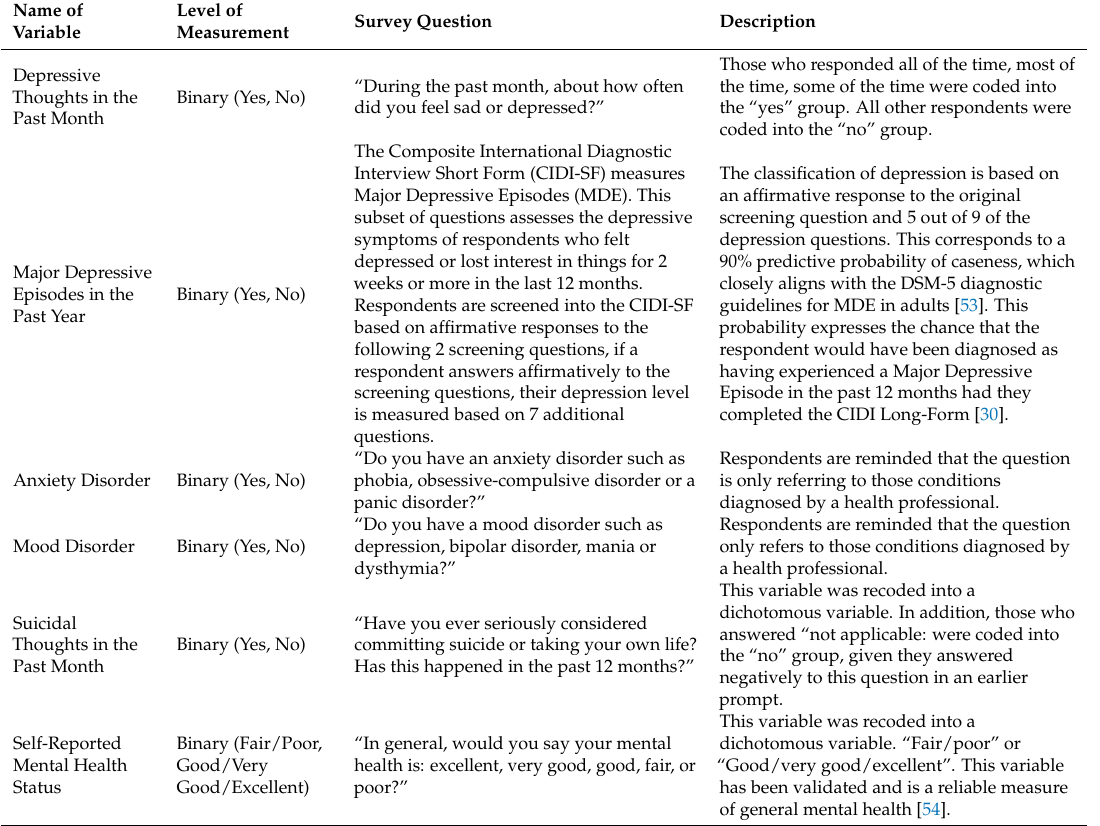
Table A2. Description of Outcome Variables Included in